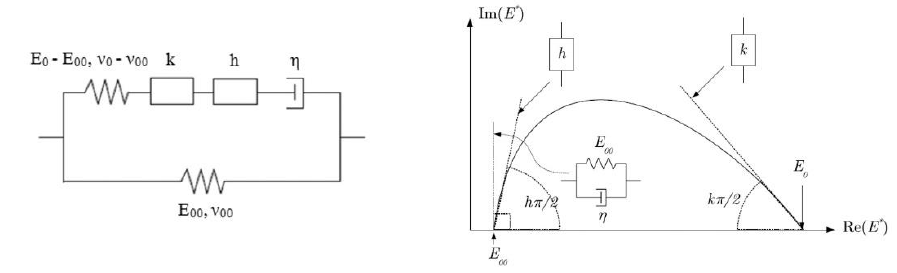
Figure 2. 2S2P1D schematic model.